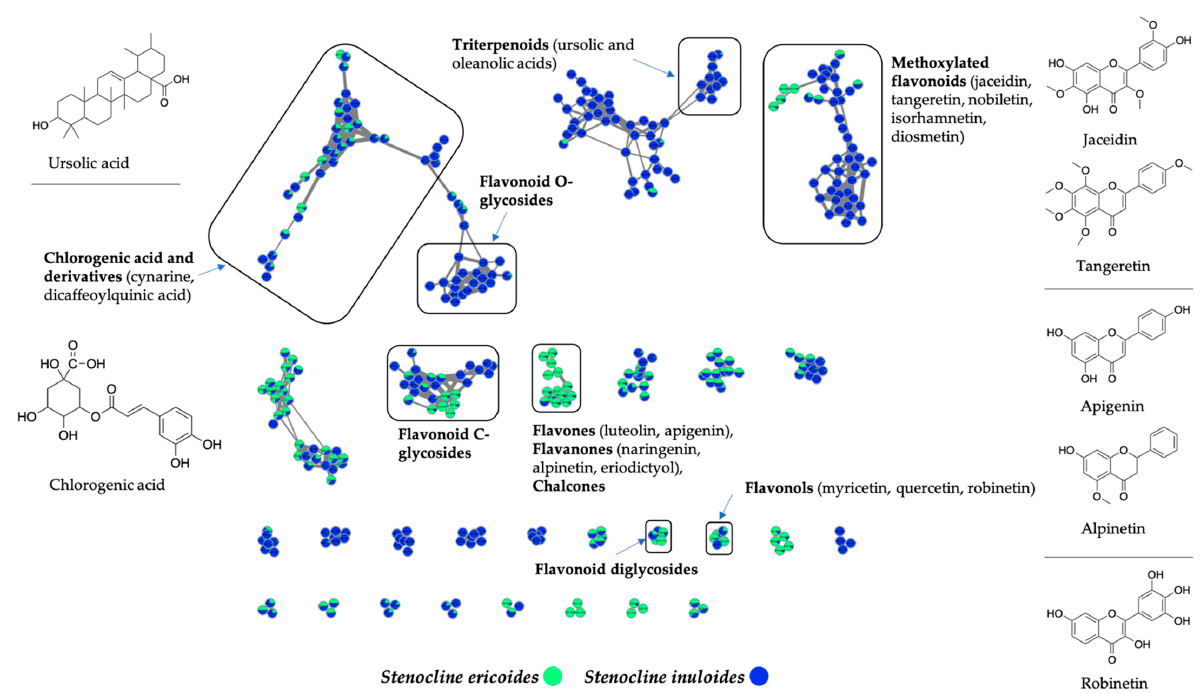
Figure 5. S. ericoides (green) and S. inuloides (blue) are polyphenol-rich species. The molecular networks were created by MetGem from the spectra file exported from Progenesis QI. The annotations correspond to standard or analogue matches to GNPS libraries and were performed using a similarity cosine scoring ≥ 0.6.